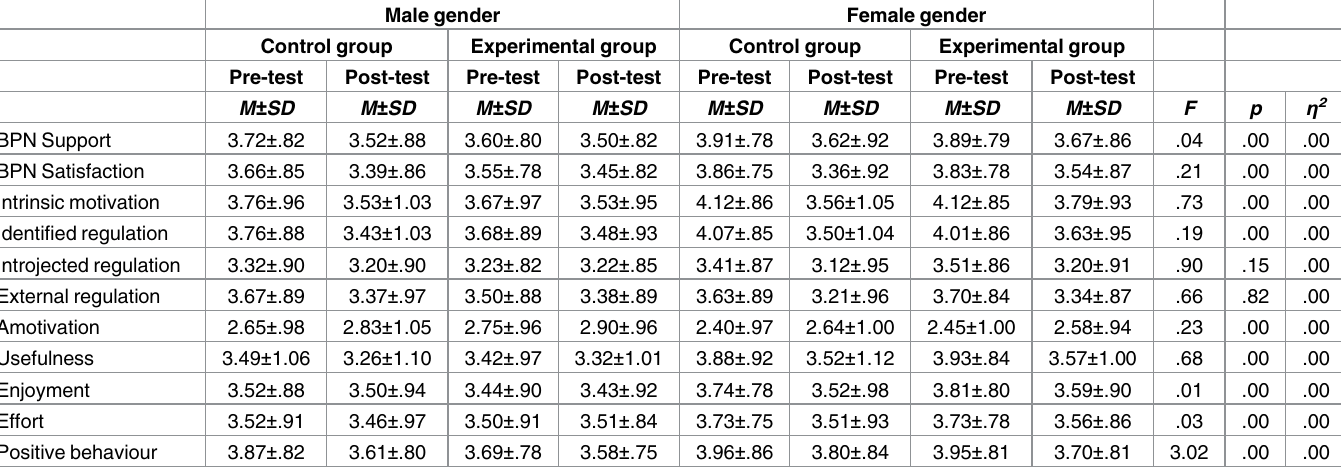
Table 3. Gender differences in repeated measuresanalysis of varianceand descriptive statistics for the dependent